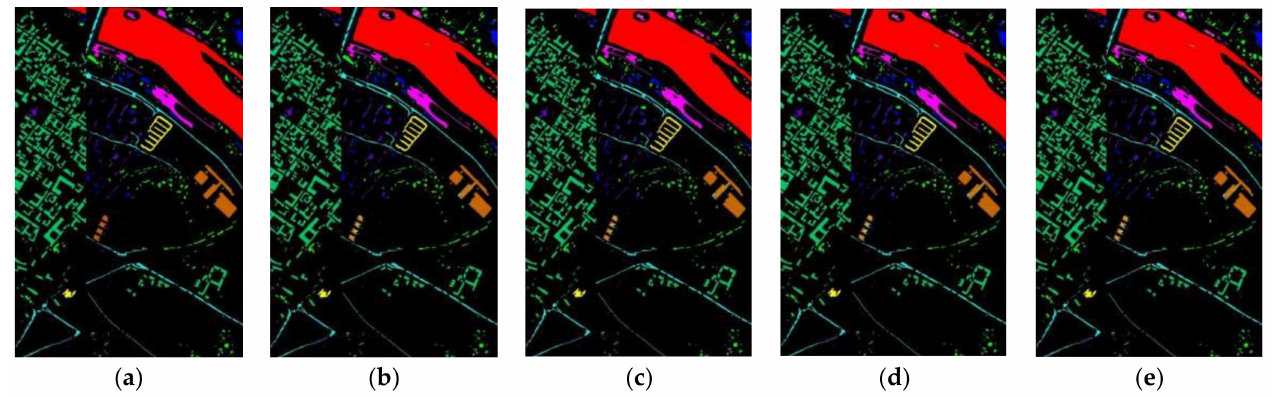
Figure 7. Pavia Center hyperspectral image classification result image. ( a ) (ground truth), ( b ) SVM,